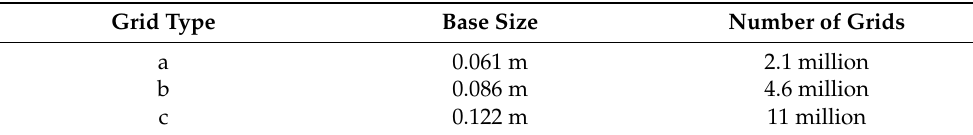
Table 3. Base size of three different grids and the total grid